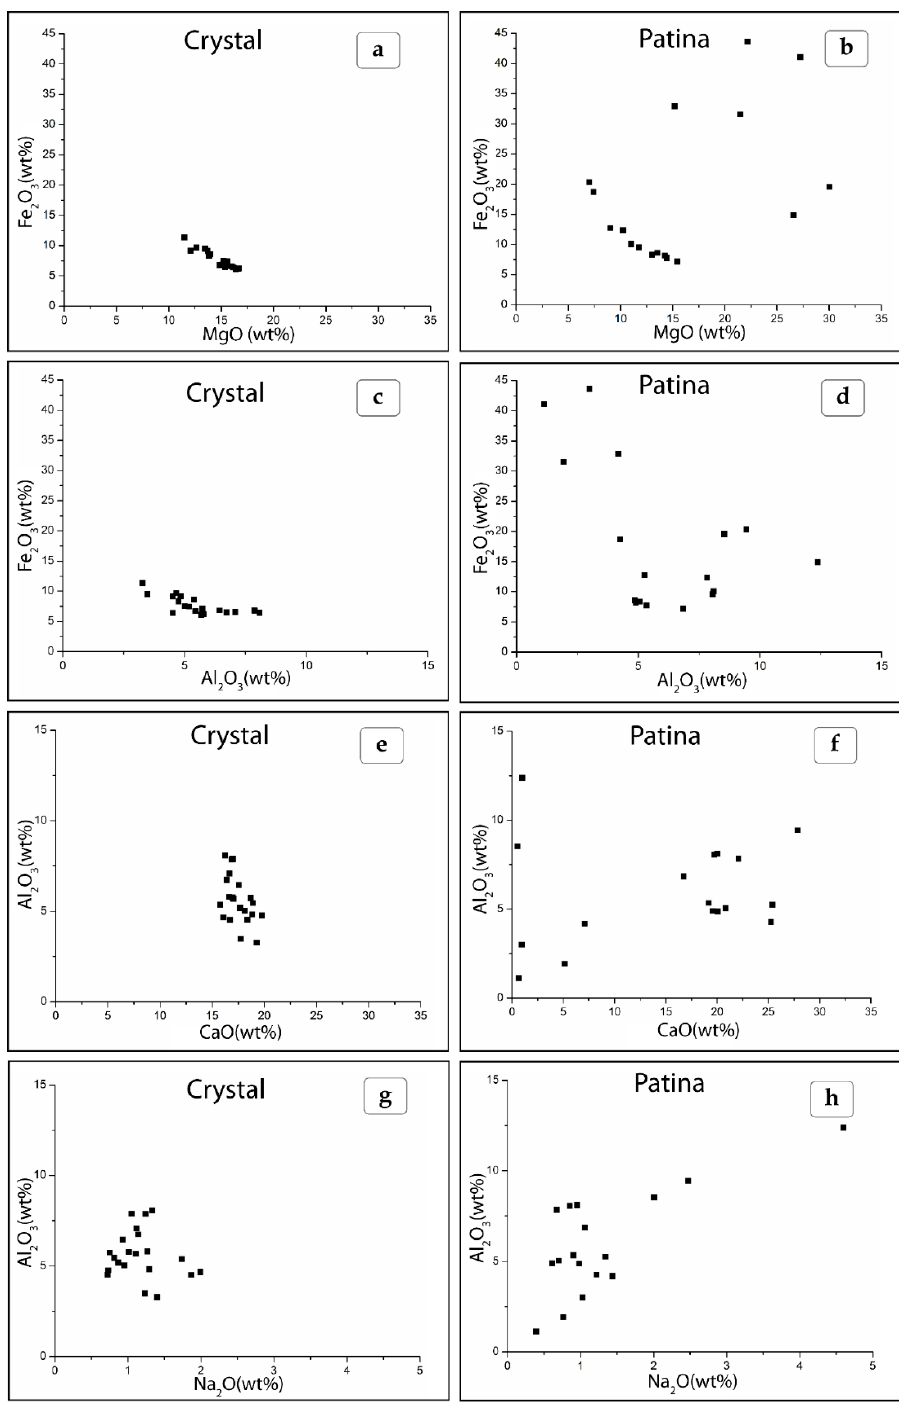
Figure 7. The scatter pot show the cation mobilization of MgO, Fe 2 O 3 , Al 2 O 3 , CaO, and Na 2 O from the crystal to the patina developed on it, during the alteration process on the clinopyroxene grains at the temperature of 150 °C and 175 °C and pH 5 and 3.5, respectively. ( a , c , e , g ) Diagrams showing the composition of clinopyroxene crystals where the absence and the incipient formation of the patina respectively occur ( b , d , f , h ) Scatter plot showing the mobilization of the chemical elements in the patina developed on clinopyroxenes. The chemical elements indicate a clear increase of ( d ) Fe 2 O 3 and Al 2 O 3 , coupled in more cases with ( b ) which indicates the formation of smectite as Fe–Mg saponite.